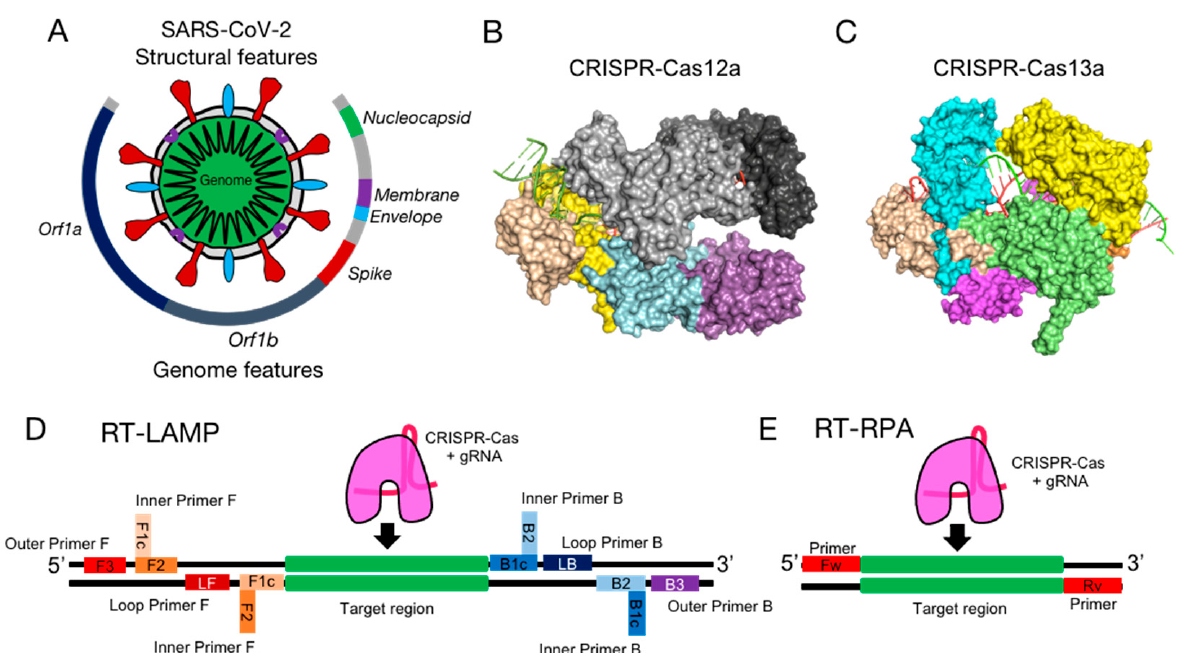
Figure 1. ( A ) Structural and genome features of SARS-CoV-2 virion. Class 2 CRISPR–Cas proteins extensively used in genetic diagnostics: ( B ) LbCas12a (type V, PDB: 5XUS) [28] (left) and ( C ) LbuCas13a (type VI, PDB: 5XWP) [29] (right). Colors represent different domains of Cas proteins. LbCas12a: Wedge I, II, and III (yellow), REC1 (light gray), REC2 (dark gray), PI (wheat), RuvC-I, II, and II (cyan), BH (green lime), and Nuc (magenta). LbuCas13a: NTD (cyan), Helical-1 (wheat), HEPN1-I and II (green lime), Helical-2 (yellow), Linker (orange), and HEPN2 (magenta). Schematics depicting DNA in black and the primers used for isothermal amplification methods in colors: RT-LAMP ( D ) and RT-RPA ( E ) and the target sequence for CRISPR–Cas systems (green).